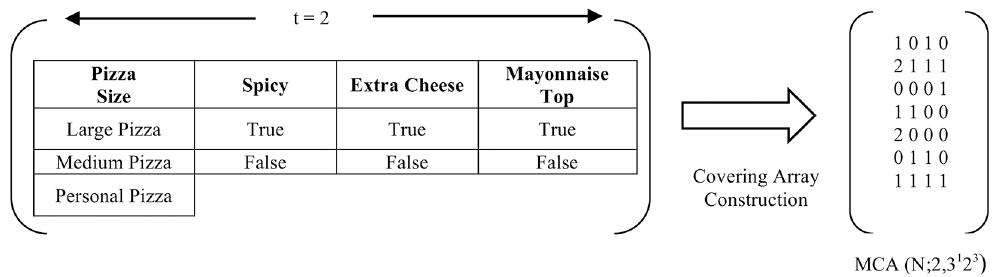
Fig 2. Mixed covering array construction MCA ( N ;2, 3 1 2 3 ) for Acme vegetarian pizza order system.